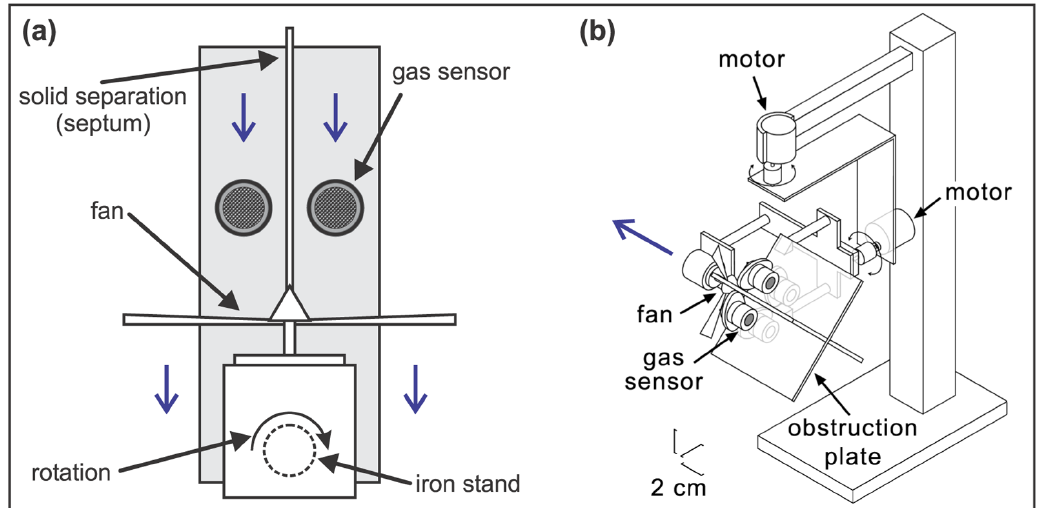
Figure 16 . (a) Sketch that shows the functional principle of the two-dimensional odour compass (top view), adapted from [5]. (b) Three-dimensional odour compass (by courtesy of Hiroshi